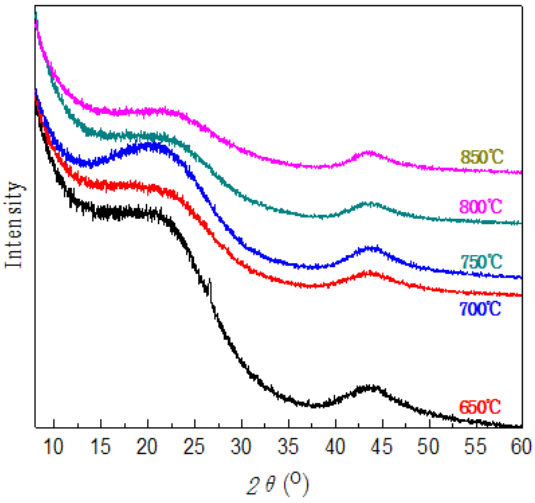
Figure 3. XRD of BACFs at various temperatures.